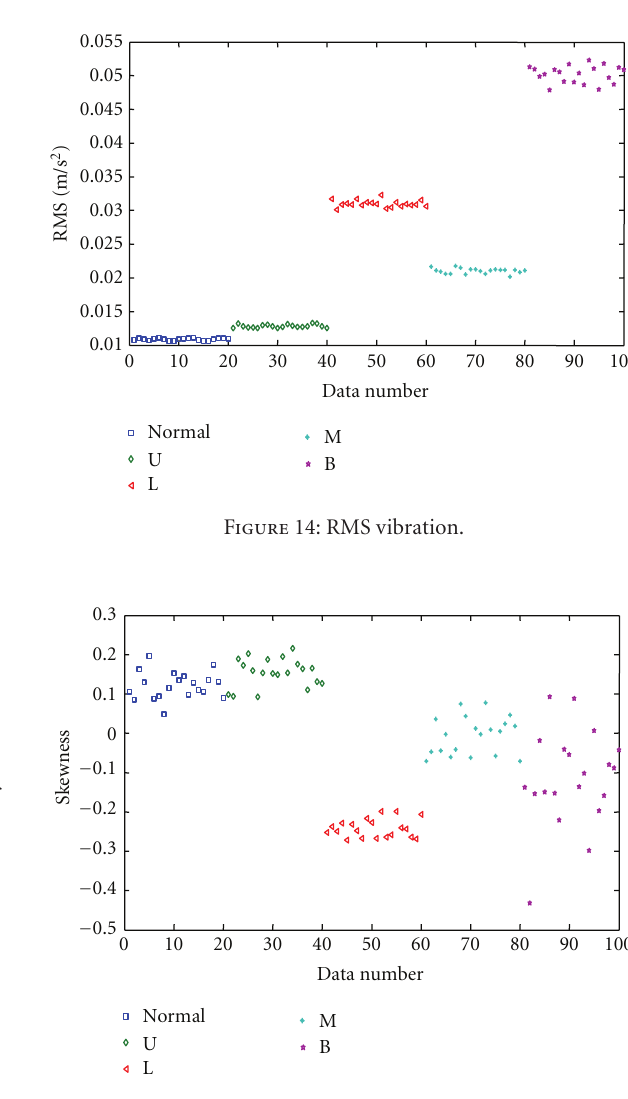
Figure 15: Skewness